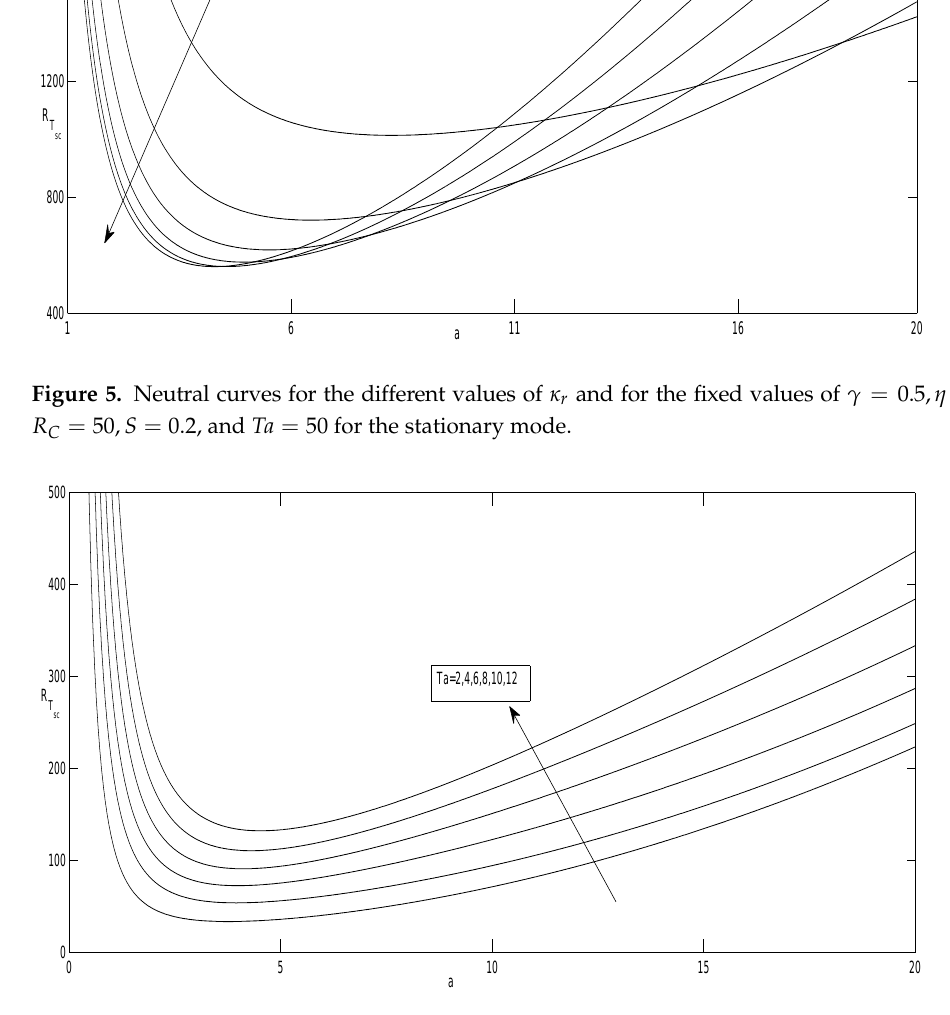
Figure 6. Neutral curves for the different values of Ta and for the fixed values of γ = 0.5, η = 0.2, R C = 50, and κ r = 1 for the oscillatory